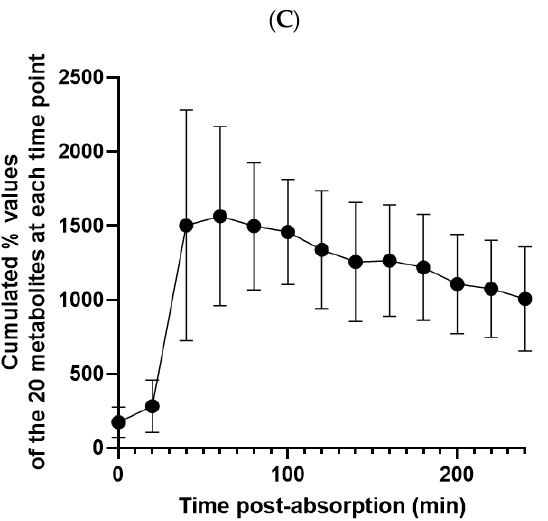
Figure 2. Absorption profile. ( A , B ) Circulating polyphenol metabolites resulting from human absorption and metabolization of TOTUM-070. For each metabolite, 100% is the highest post-absorptive AUC value. ( C ) Metabolites diversity per time point following TOTUM-070 ingestion (cumulated percentage values of the 20 metabolites at each time point ± SD).